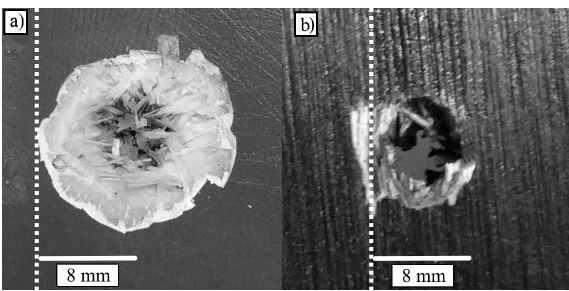
Figure 2. Resulting crater of the 7.62 mm FMJ (Full Metal Jacket) bullet impacted in ( a ) the fiberglass-